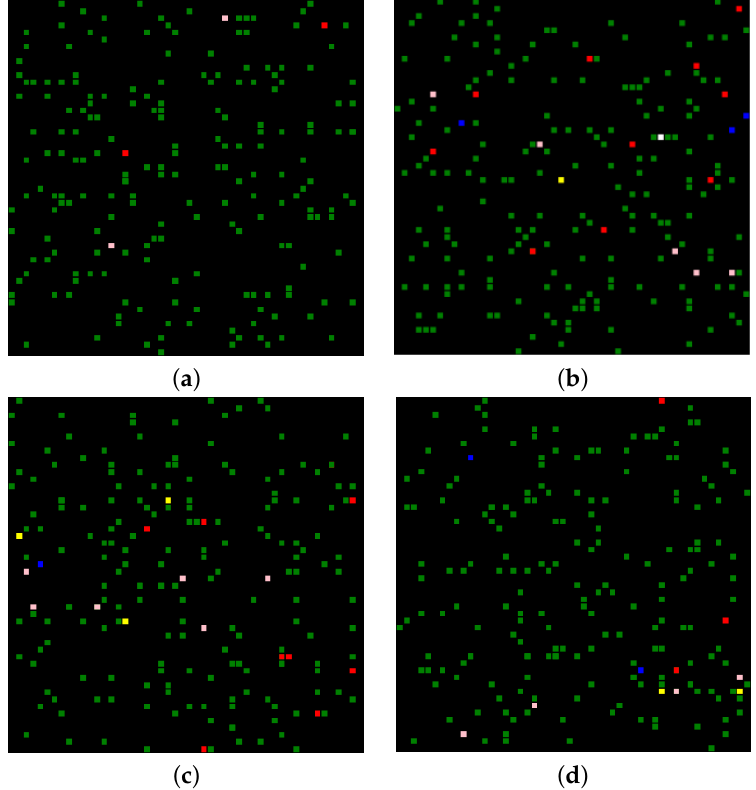
Figure 8. Simulations of the model according to parameter values from Table 4. With ( a ) the initial situation, ( b – d ) display the disease evolution up to a given time t